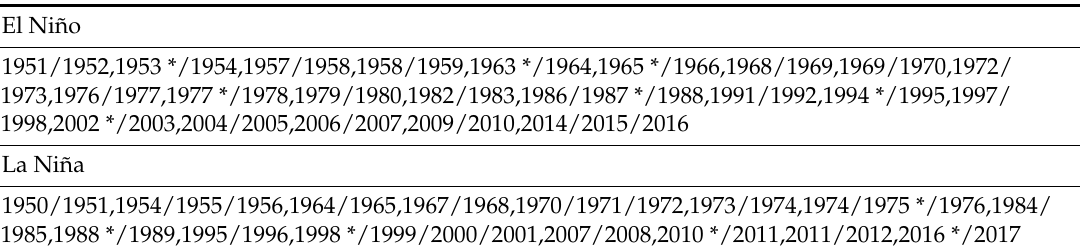
Table 1. Years dominated by different ENSO events during